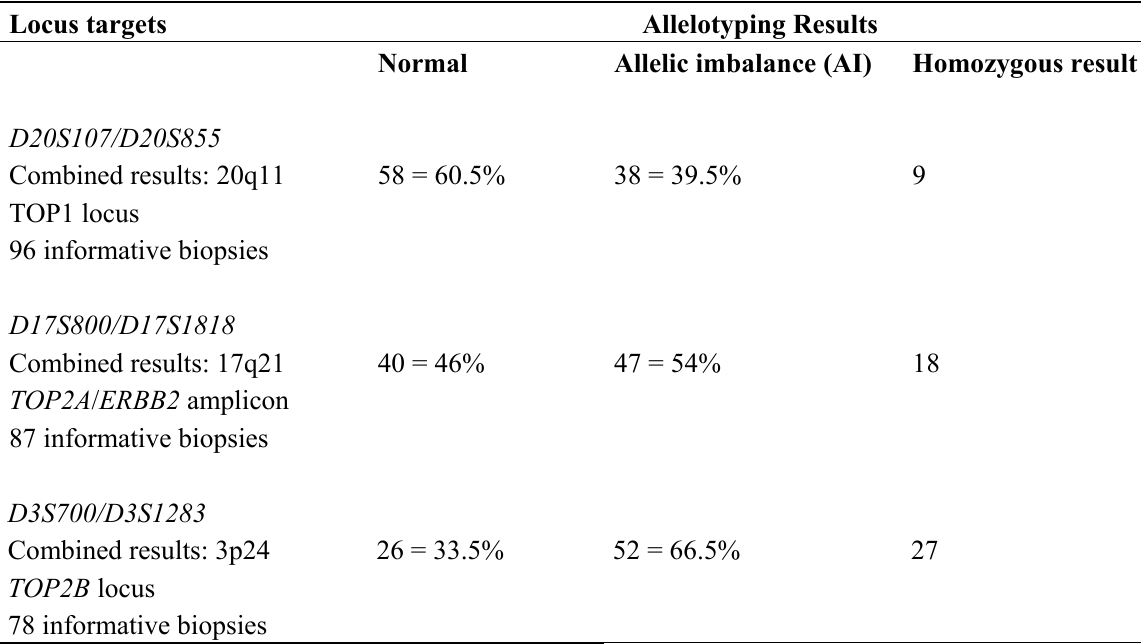
Table 2. Microsatellite analyses in 105 pediatric high grade osteosarcomas (results expressed in patient numbers followed by the percentage, homozygous results are the non informative biopsies).